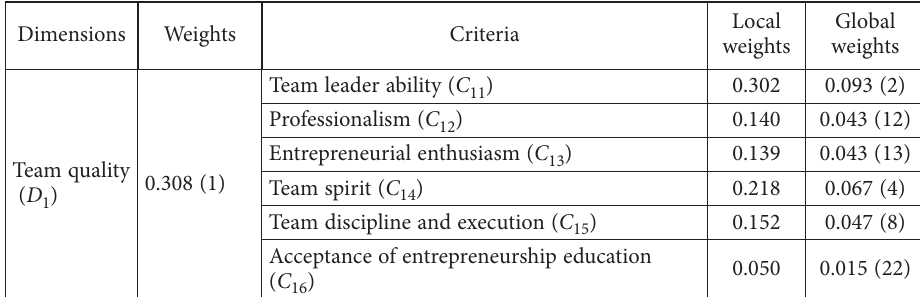
Table 7. Summary of dimensions and weights of